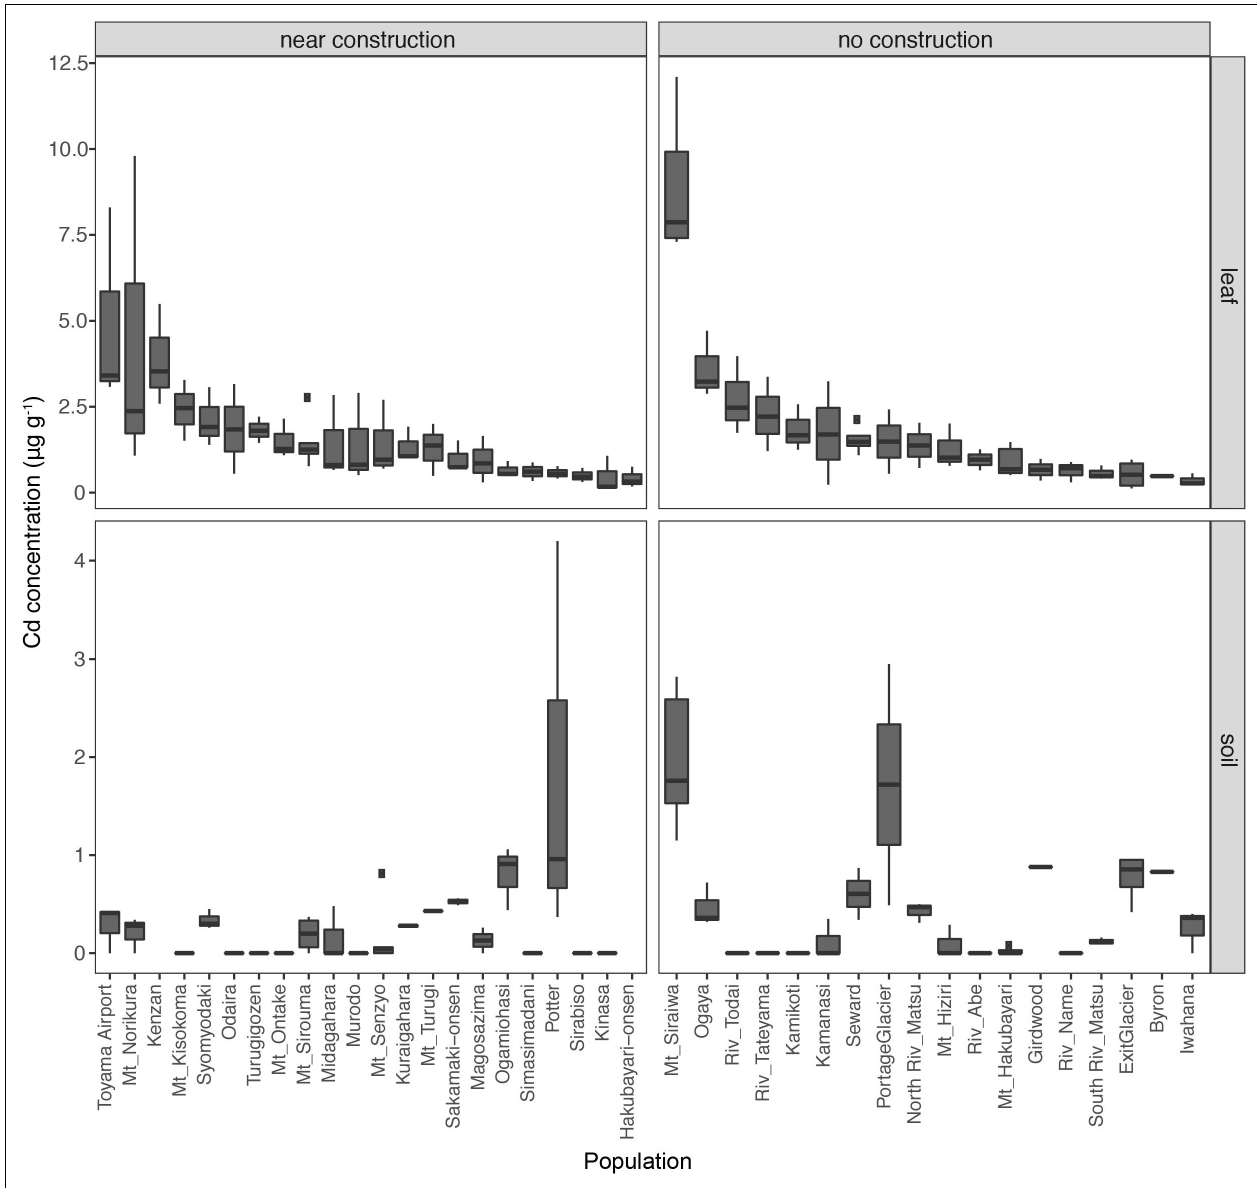
FIGURE 2 | Leaf concentrations of cadmium (Cd) in 40 natural populations of A. kamchatica (Upper) . Soil concentrations of Cd (Lower) at 38 corresponding sites. Populations were grouped into near construction or no construction types. The populations are sorted from highest to lowest Cd concentration in the leaf samples. The y -axis is the Cd concentration in µ g per gram of dry weight. Note the different y -axis scales for leaf and soil samples. Boxplots: center line, median; box limits, upper and lower quartiles; whiskers, 1.5 × interquartile range; points, outliers. The correlations between leaf accumulation and soil concentrations: [near construction Pearson’s r = –0.08, (no construction) Pearson’s r = 0.58 (see Supplementary Figure 1 )]. Refer to Supplementary Table 1 for mean values, variance, number of replicates, and location information.